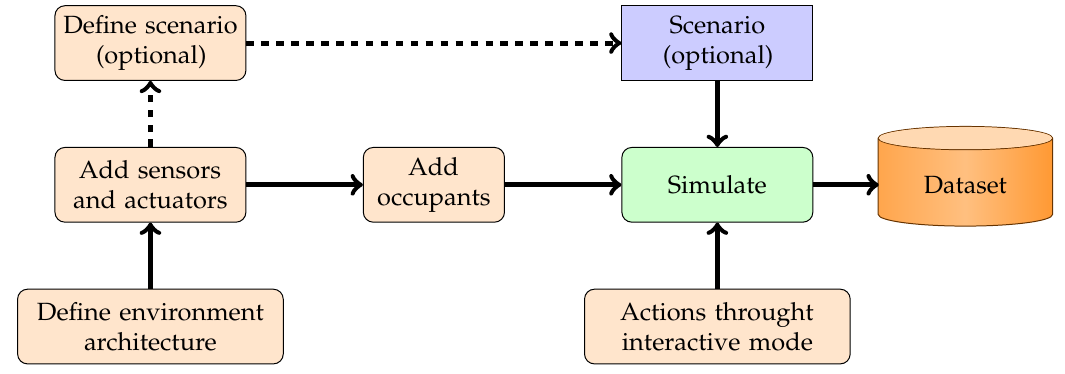
Figure 10. Scheme giving an overview of the design